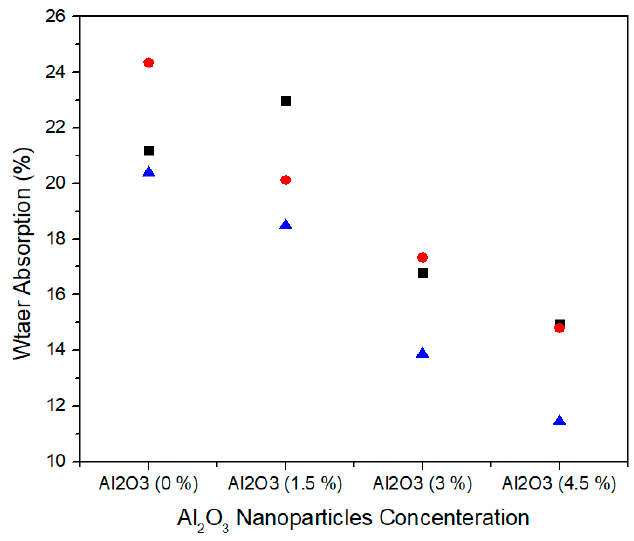
Figure 17. Numerical values of water absorption of various treatments of alumina nanoparticles.